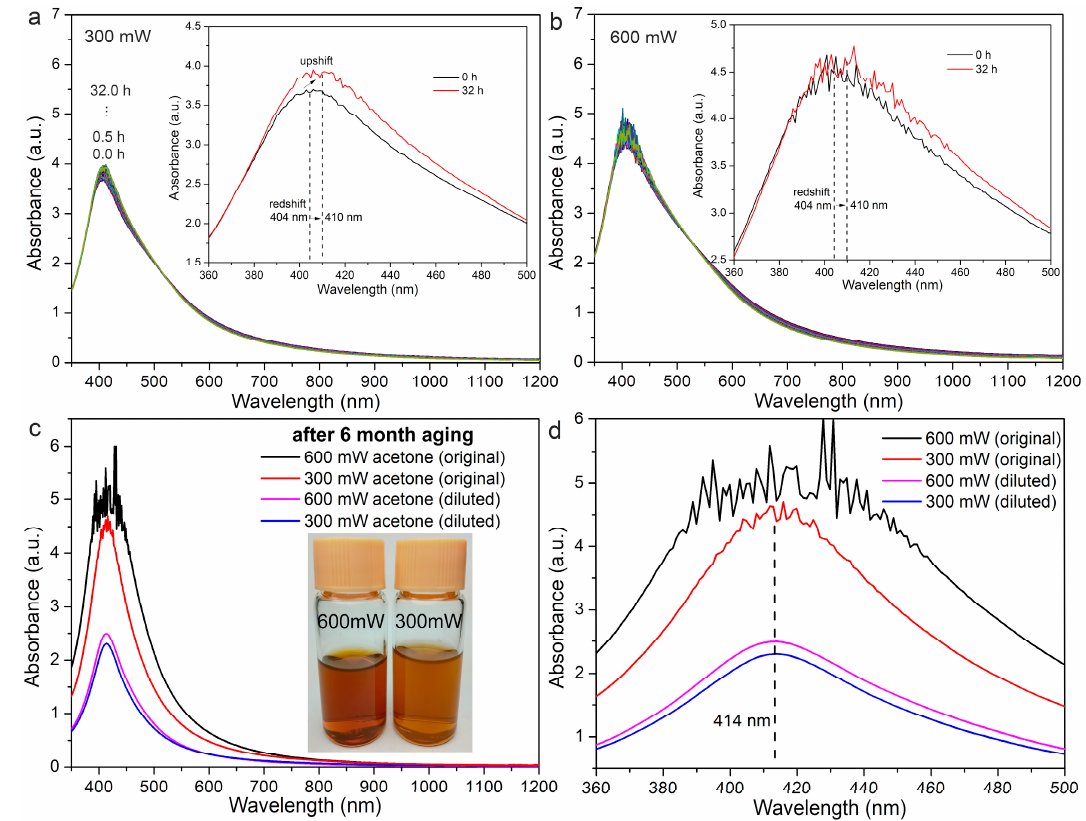
Figure 1. Absorption spectra for Ag nanoparticles (NPs) synthesized by laser ablation of Ag in acetone, and then stored for various periods. Upper: spectra for samples prepared at a laser power of ( a ) 300 mW and ( b ) 600 mW, and stored within 32 h (insets: enlarged spectra in the wavelength range of 360 nm to 500 nm for samples stored for 0 and 32 h). Lower: spectra for ( c ) samples prepared at laser powers of 300 mW and 600 mW, and stored for six months (inset: photos of aged Ag NPs in acetone), and ( d ) enlarged spectra in the wavelength range of 360 nm to 500 nm (black and red curves: as-aged colloidal samples; pink and blue curves: diluted as-aged samples prepared by the addition of pure acetone to the colloids).